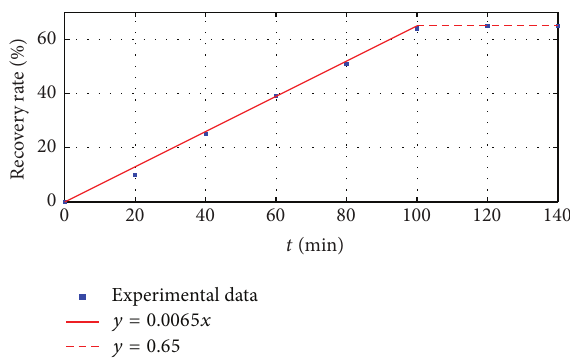
Figure 4: The fitting curve of the relationship between recovery rate of SDA and the time of passing gas A